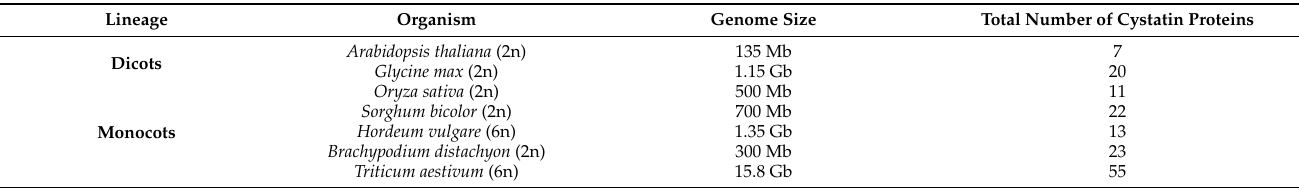
Figure 2. Phylogenetic and conserved domain analysis of the TaCystatin family. ( a ) Phylogenetic tree of TaCystatins. The ML tree was constructed on the basis of the full-length amino acid sequences of TaCystatins by MEGA X, with a set of 1000 replications. All TaCystatins were divided into three phylogenetic groups. ( b ) Conserved domain of 55 TaCystatins. Table 2. Number of cystatin proteins in seven different species.